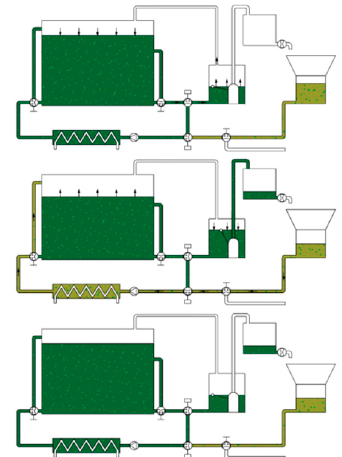
Figure 5. Schematic representation of the feeding procedure to avoid abrupt changes in pressure.